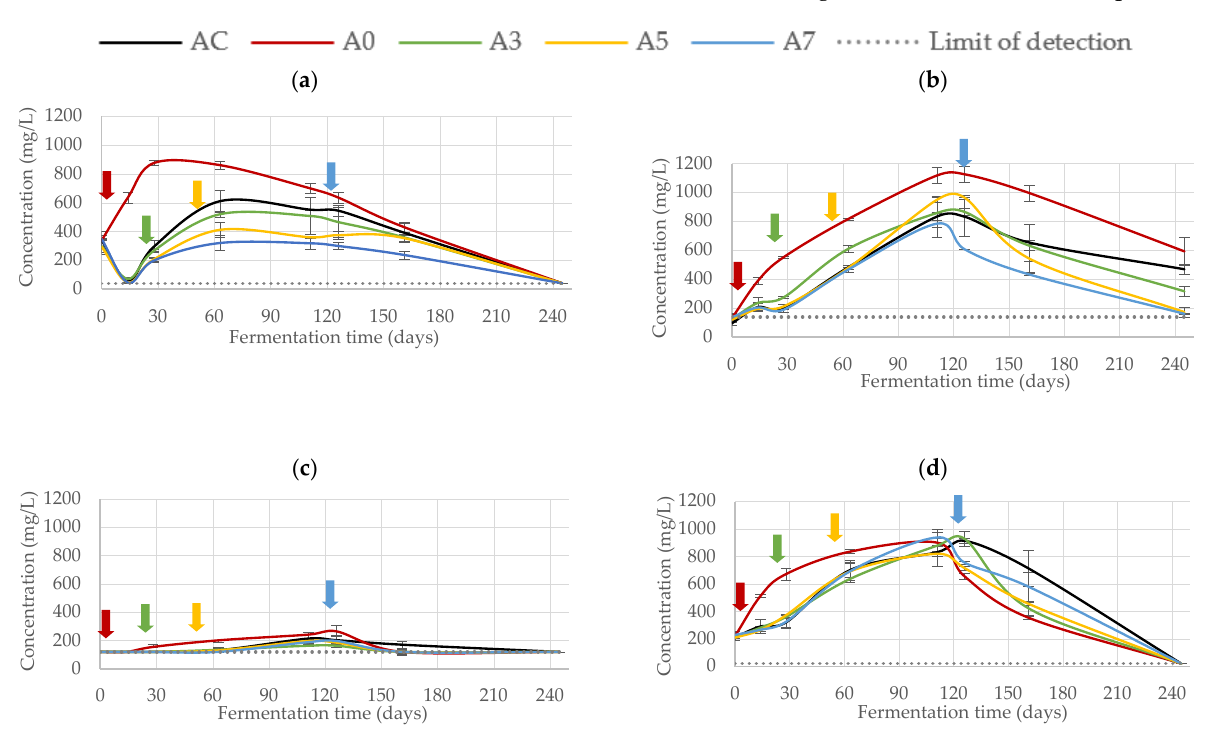
Figure 5. Evolution in phenolic profile, ( a ) oleuropein, ( b ) hydroxytyrosol, ( c ) tyrosol, and ( d ) verbascoside, of table olive brine throughout fermentation under plan A. Arrows indicate the moment of inoculation with Lpb. pentosus i106 and the corresponding salt addition to all